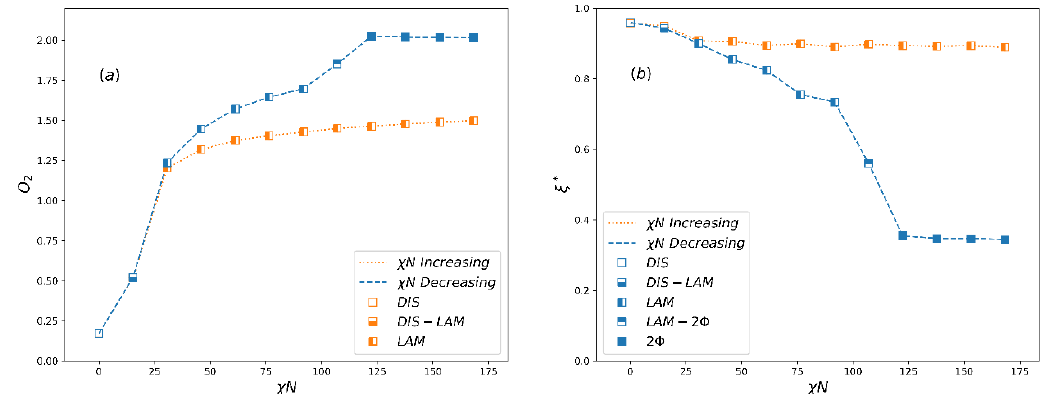
Figure 9. ( a ) The averaged order parameter, O 2 , and ( b ) the normalized extent of reaction, ξ ∗ , as a function of χ N , for A5B5 SDC systems. DIS denotes a disordered state, DIS-LAM denotes a coexistent